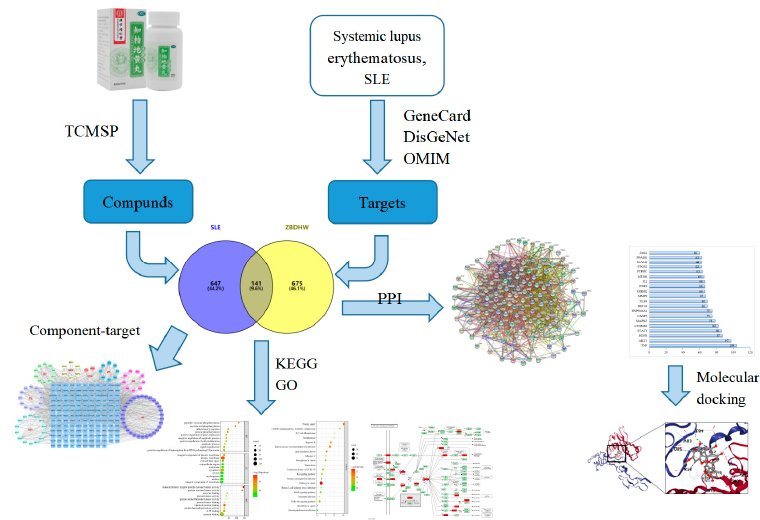
Figure 1. Flow chart of the study.